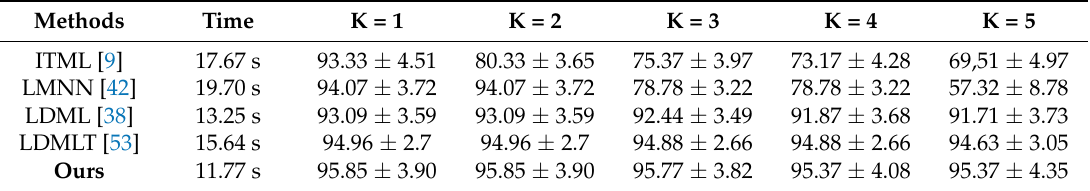
Table 3. The average of recognition rate (%) and training time for different metric learning methods in the USTB2 database.